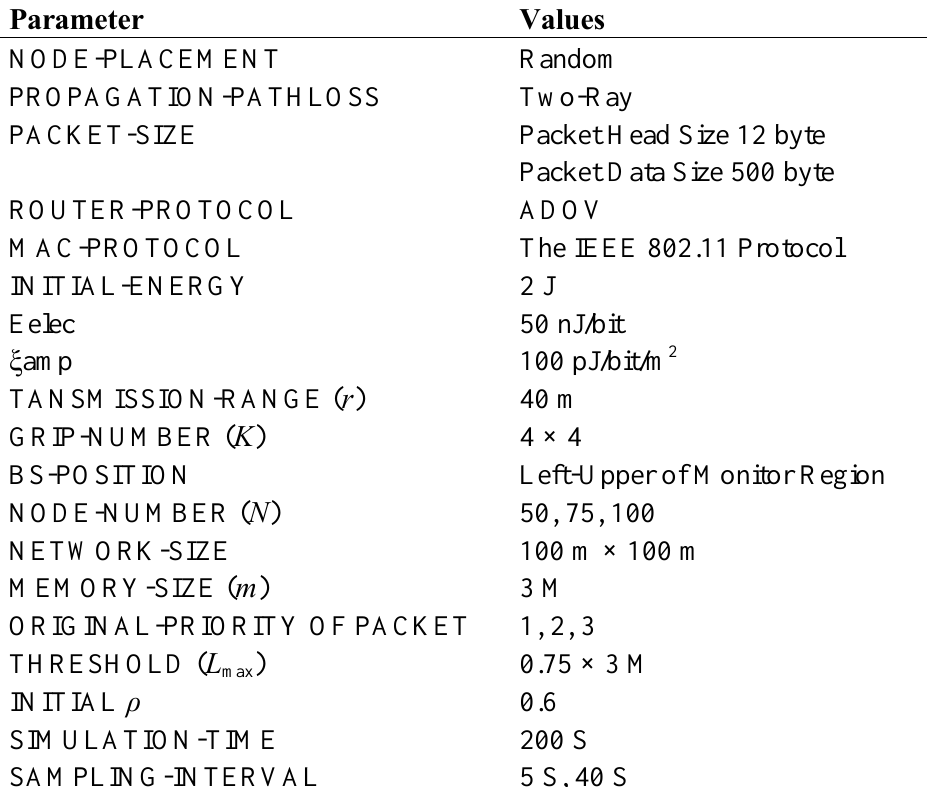
Table 1. The setting of parameters in the